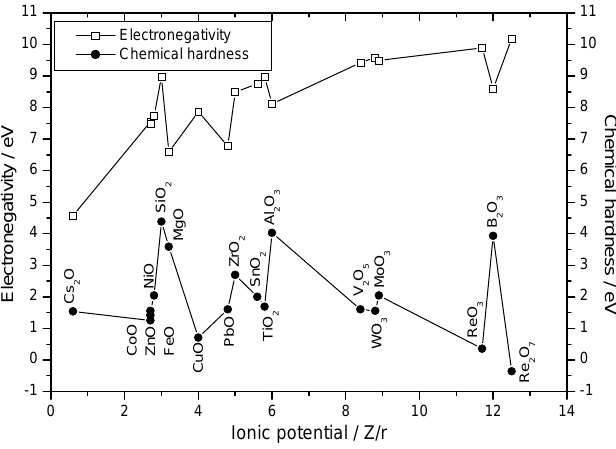
Figure 5. Relationship among electronegativity, chemical hardness, and ionic potential of certain solid oxides with coordination number of 6. (Data of ionic potentials of solid oxides are from Ref.